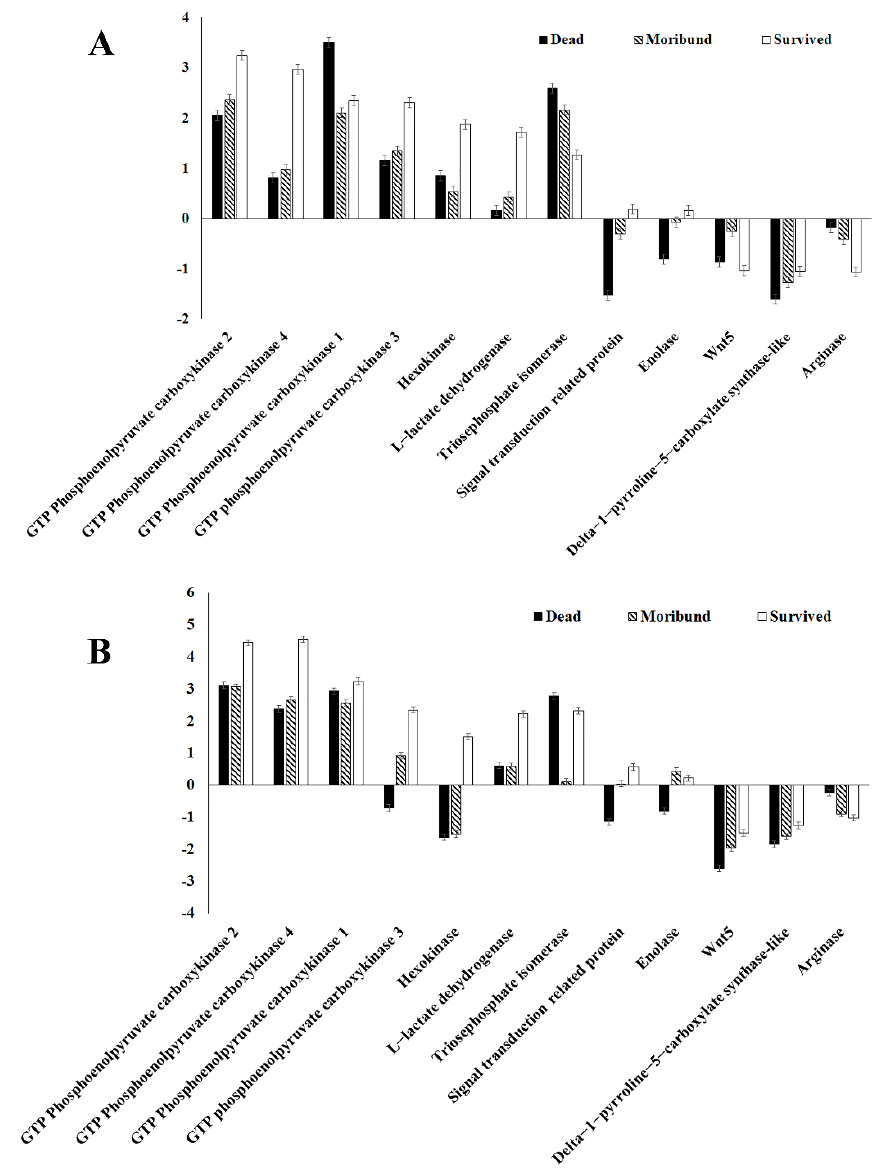
Figure 5. Metabolism validation of selected genes by RNA-seq ( A ) and qRT-PCR ( B ) in Macrobrachium nipponense .